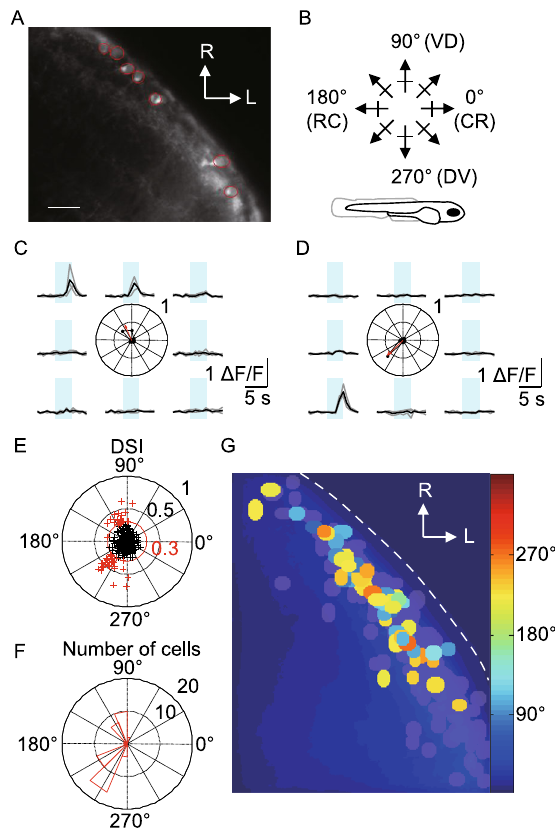
Figure 2. Direction selectivity of SINs. (A) Fluorescent signal in Gal4s1156t, UAS:GCaMP-HS larva. Region of interests (ROIs) are demarcated by red lines. (B) Schematic showing direction of motion of bars relative to fi sh body axis (Bottom). VD: ventral to dorsal. DV: dorsal to ventral. (C and D) Ca 2+ transients from two somata. Center: polar plot of normalized peak amplitudes of Ca 2+ transients. Arrow shows vector sum of normalized peak amplitudes, indicating PD and DSI. (E) DSI and PD for all somata. Red circle marks a DSI of 0.3, used as criterion for DS. (F) Histogram of PDs for all DS cells from (E) in red. (G) All responsive somata from grouped experiments, color- coded according to PD. Gray somata showing responsive but not DS cells (total number of cells imaged: 304; responsive cells: 247, 81.3%). Scale bar, 20 μ